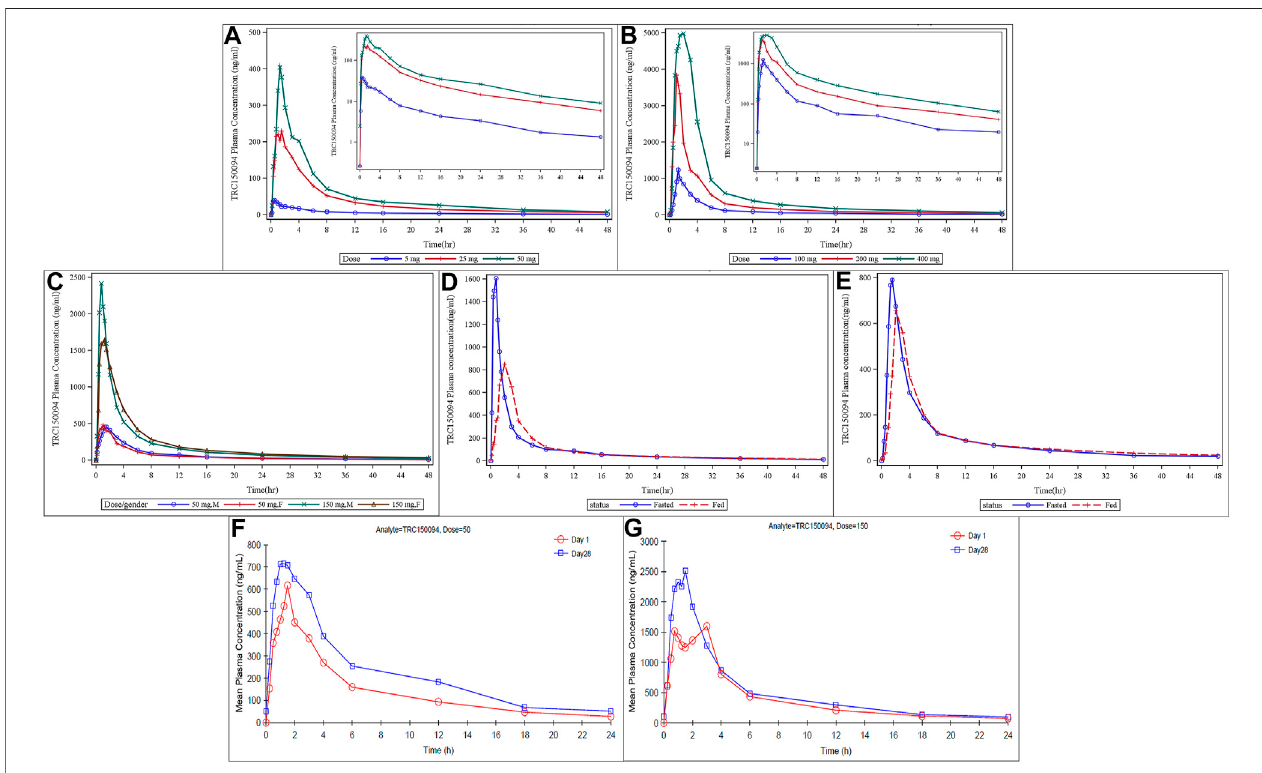
FIGURE2| MeanplasmaconcentrationofTRC150094insingleascendingdosestudy(adults,elderlysubjects,andfoodeffectstudy)andmultipleascendingdose study. (A,B) In adults at lower doses (5, 25, and 50 mg) and at higher doses (100, 200, and 400 mg) (C) In elderly by dose and sex (D,E) Food status in females and in males (F,G) Mean plasma concentration of TRC150094 versus time curves after administration of TRC150094 on days 1 and 28 at 24 h, with 50 and 150 mg doses.